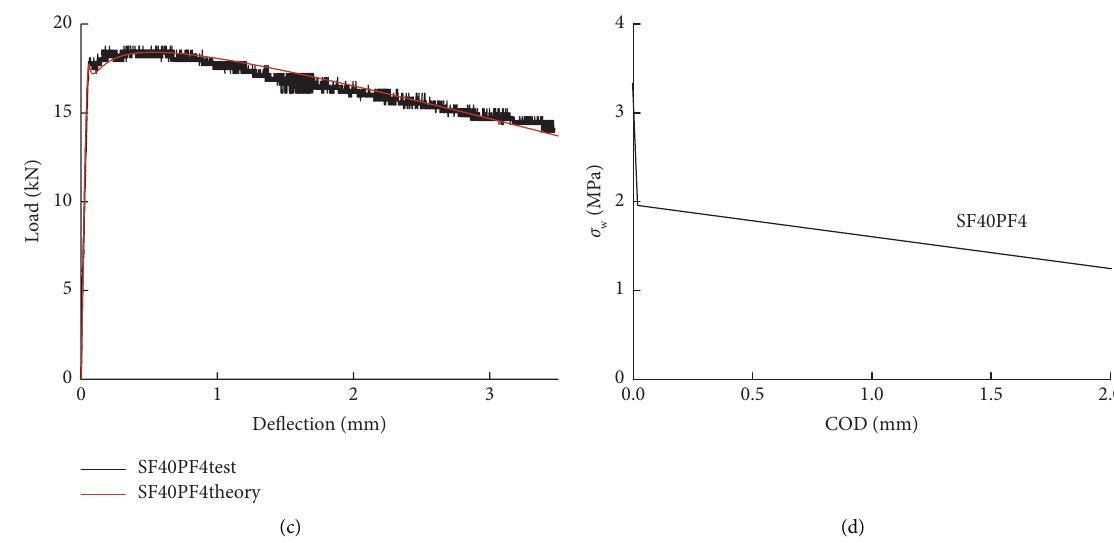
Figure 13: Te evaluation of load-defection curves concerning the test and theory of beams SF20PF6 and SF40PF4. (a) Te evaluation of load-defection curves concerning test and theory. (b) Te tensile stress-crack opening relationship. (c) Te evaluation of load-defection curves concerning test and theory. (d) Te tensile stress-crack opening relationship. Table 8: Ultimate shear load, average value, and coefcient of variation of